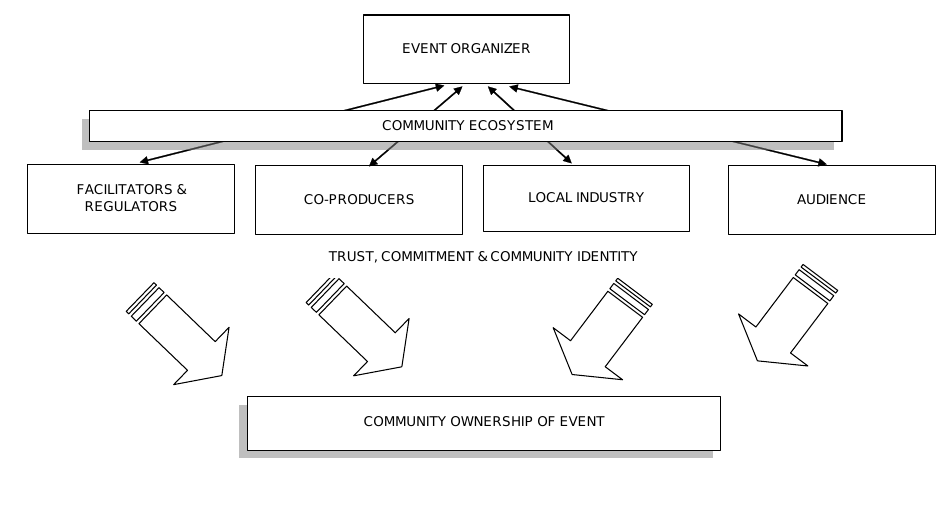
Figure 2: A Conceptual Model for Community